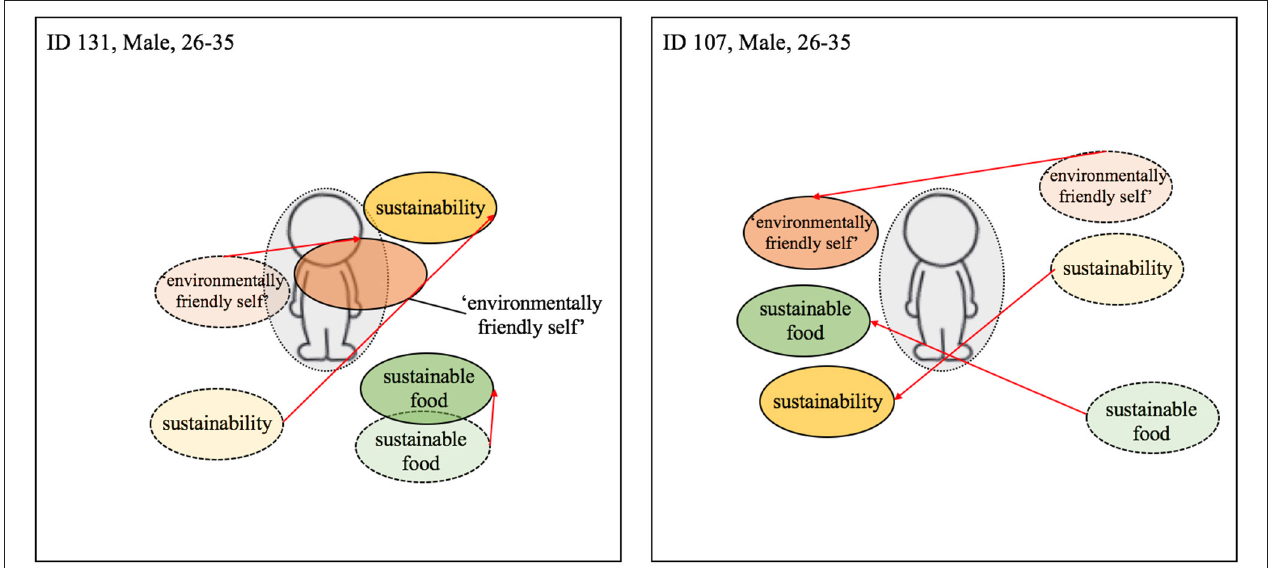
FIGURE 3 | Visualization of centrality of identity—Reduced meat consumption. Dashed line = T1; solid line and darker coloring = T2; Red arrow indicates change from T1 to T2 (the colors were added after the